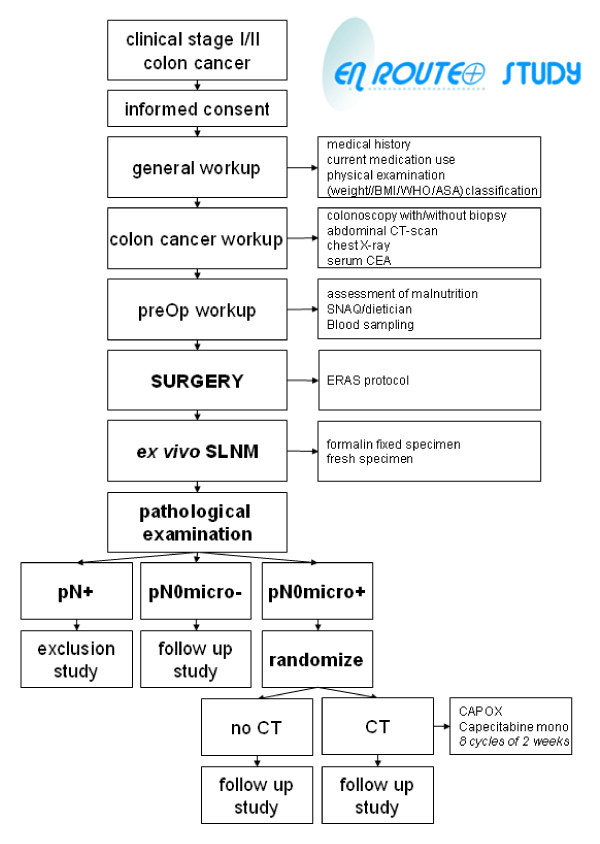
EnRoute+ flow chart